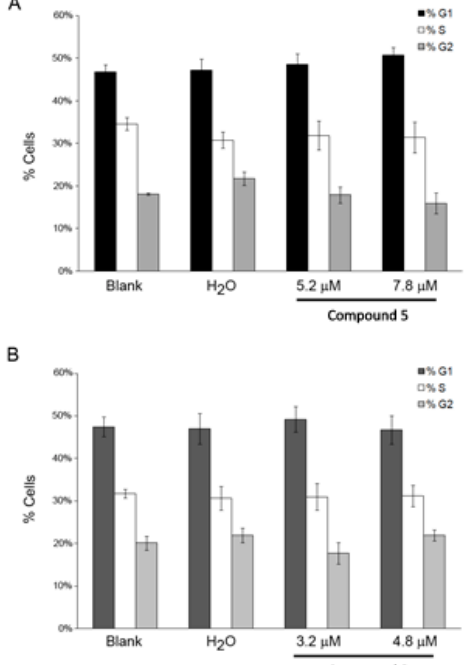
Figure 2. NCI-H460 cell cycle profile 48 h following treatment with compounds 5 ( A ) and 8 ( B ), analyzed by flow cytometry. Cells were treated with the GI 50 (5.2 μ M) and 1.5× GI 50 (7.8 μ M) of compound 5 and with the GI 50 (3.2 μ M) and 1.5× GI 50 (4.8 μ M) of compound 8 . Cells were also treated with the corresponding highest concentration of the vehicle (solvent) of the compounds (H 2 O). Results represent the mean ± SEM of at least three independent experiments.